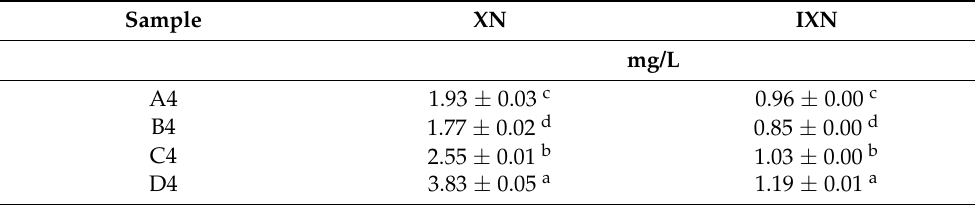
Table 3. The content of xanthohumol (XN) and isoxanthohumol (IXN) in beers.